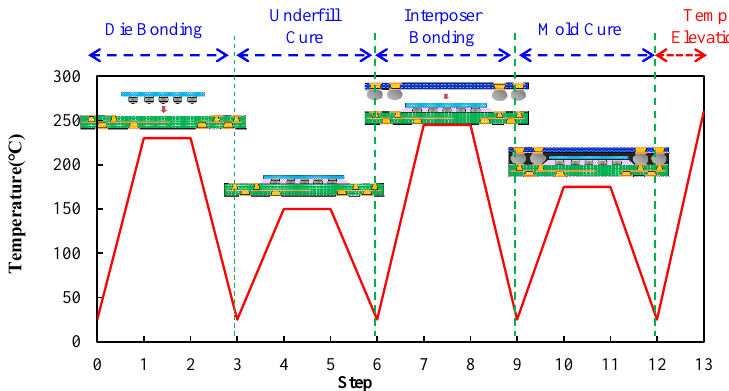
Figure 3. Fabrication process steps with temperature loads.